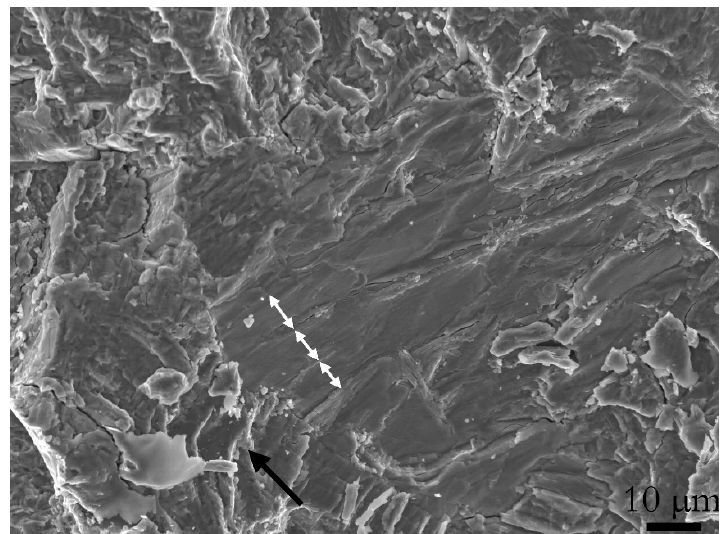
Figure 10. An area with features that resembled crack arrest marks (CAM). Each white arrow indicates a possible CAM, where each plateau could be a hydride titanium interface between cleaved hydrides. The black arrows show the crack growth